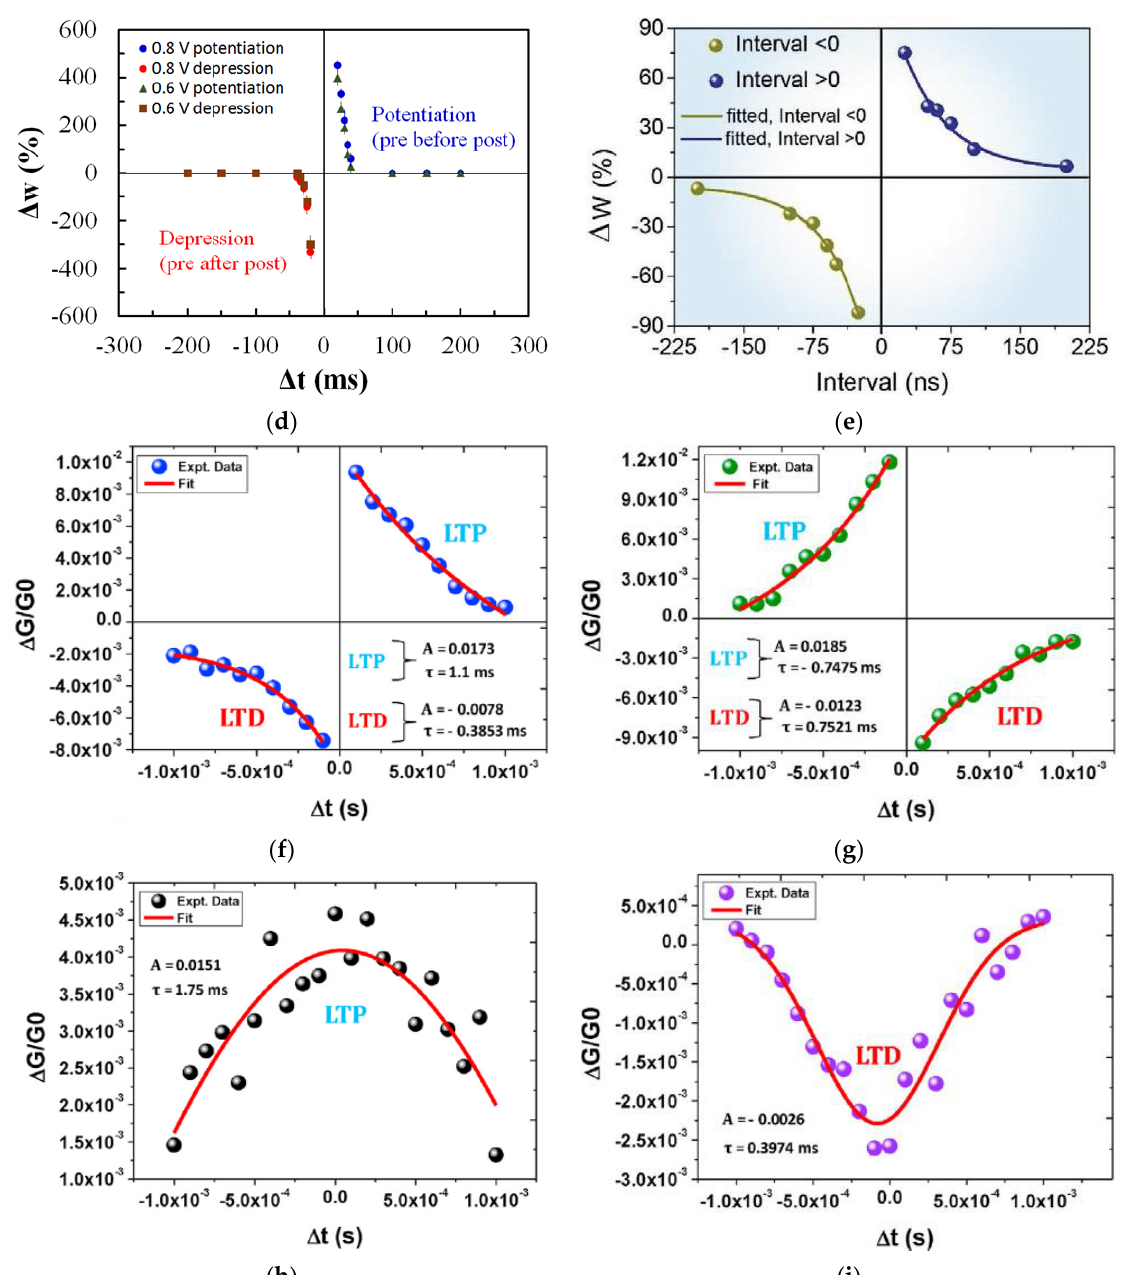
Figure 9. ( a ) Schematic diagram of memristor analogous to a biological synapse and STDP meas- urement [18]. STDP learning emulation by memristors based on various natural organic materials of ( b ) collagen [25], ( c ) bombyx mori silk [55], ( d ) honey [18], ( e ) cross-linked wool keratin [59]. ( f – i ) Four STDP learning rules: ( f ) asymmetric Hebbian, ( g ) asymmetric anti-Hebbian, ( h ) symmetric Hebbian, and ( i ) symmetric anti-Hebbian reported by trypsin-memristor [26].